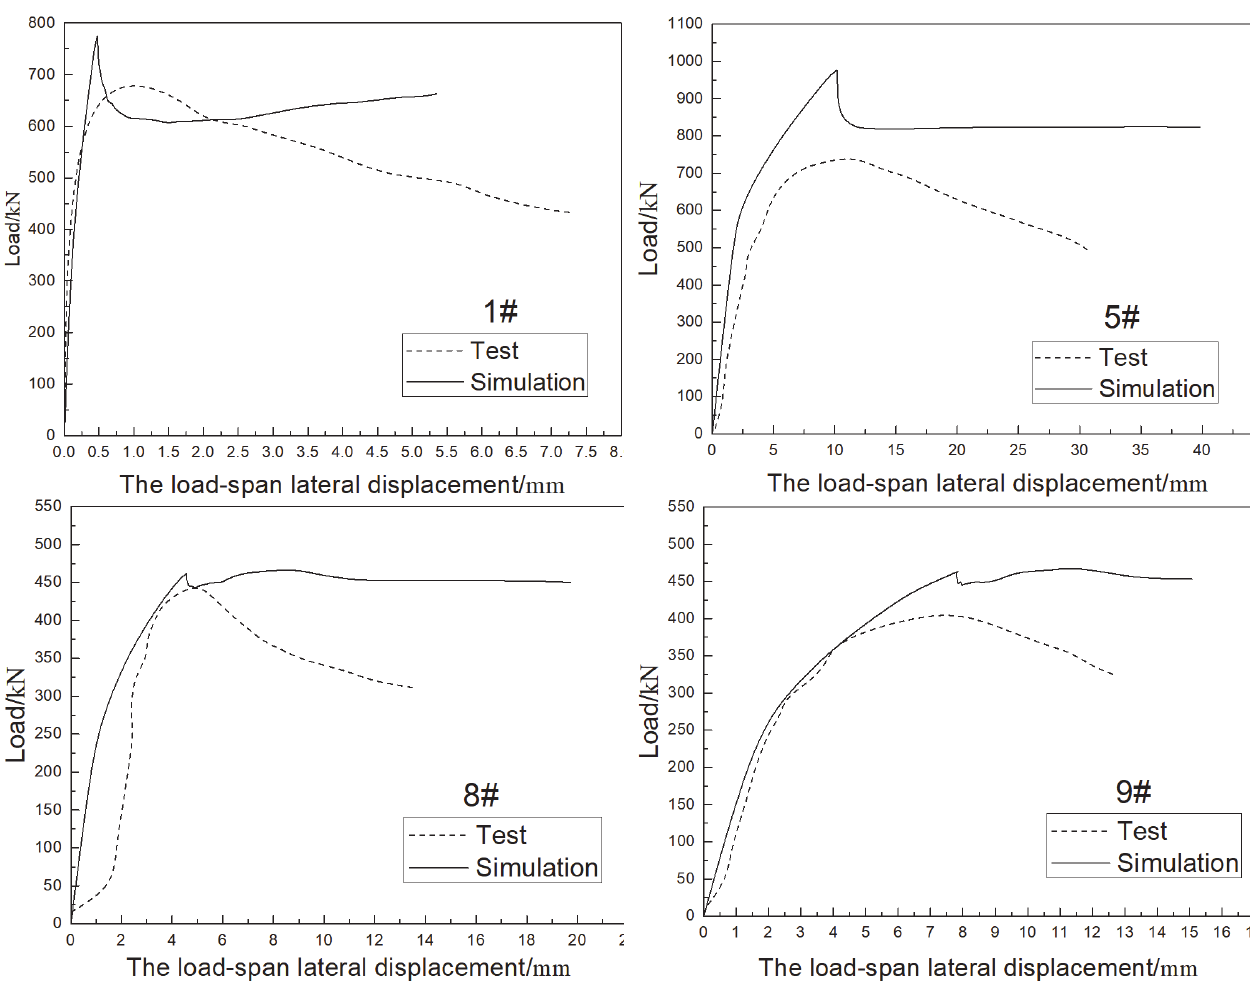
Figure 5: Comparison of the experiment results and analysis